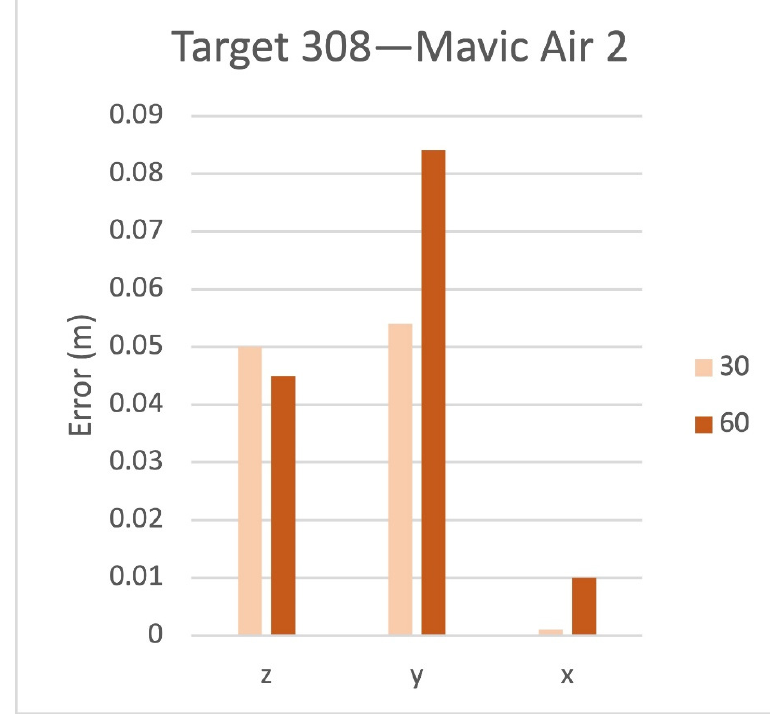
Figure 10. Residuals from the Mavic 2 Pro on CkP 308.